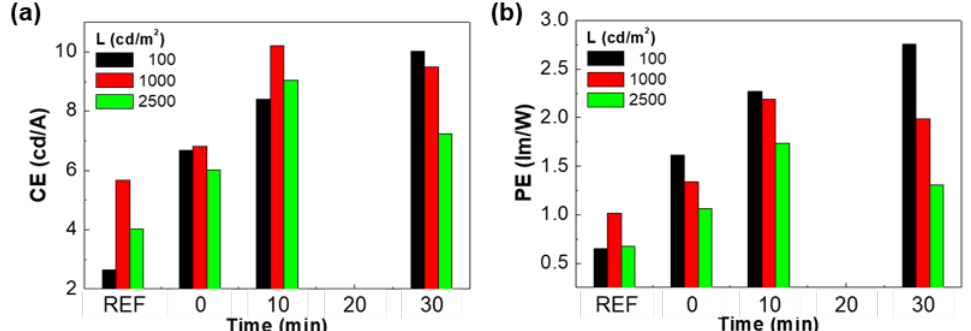
Figure 4. Comparison of efficiency at three different levels of luminance (L = 100, 1000, 2500 cd/m 2 ) for the OLEDs with the P3HT layers annealed at 140 °C for 0, 10, and 30 min: ( a ) current efficiency (CE) as a function of annealing time, ( b ) luminous efficiency (LE) as a function of annealing time. Note that the OLED without any P3HT layer is marked as REF (reference device).